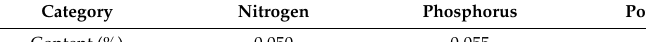
Table 3. Average nutrient content of soils in the Yellow River Delta. Category Nitrogen Phosphorus